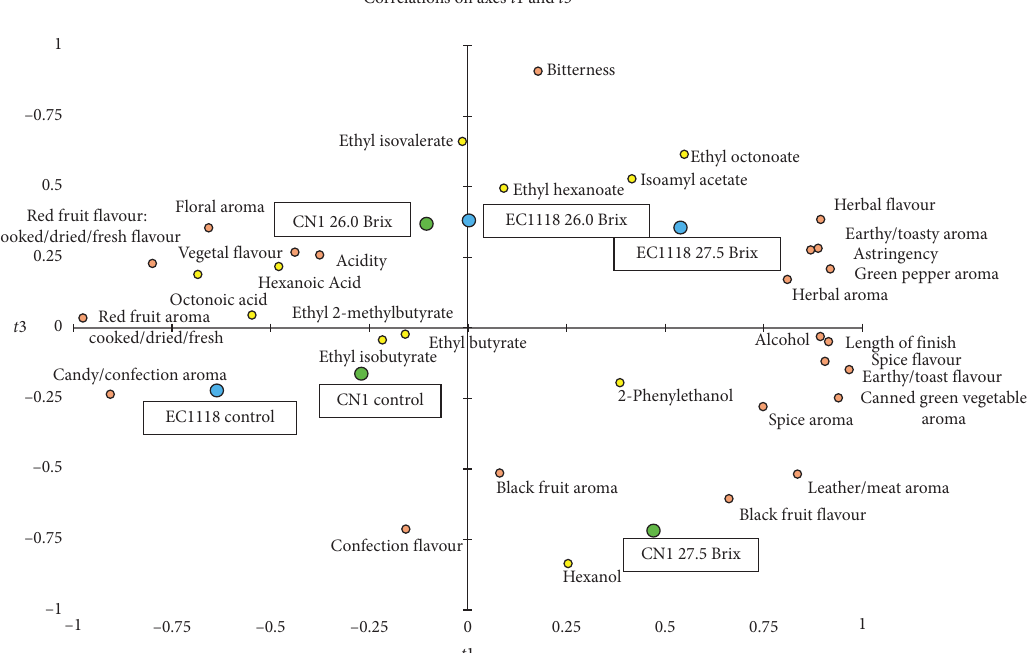
Figure 1: Impact of yeast strain and starting sugar concentration on the sensory and chemical profiles of Cabernet franc control (no dehydration) and wines made from partially dehydrated grapes as determined by partial least squares analysis.